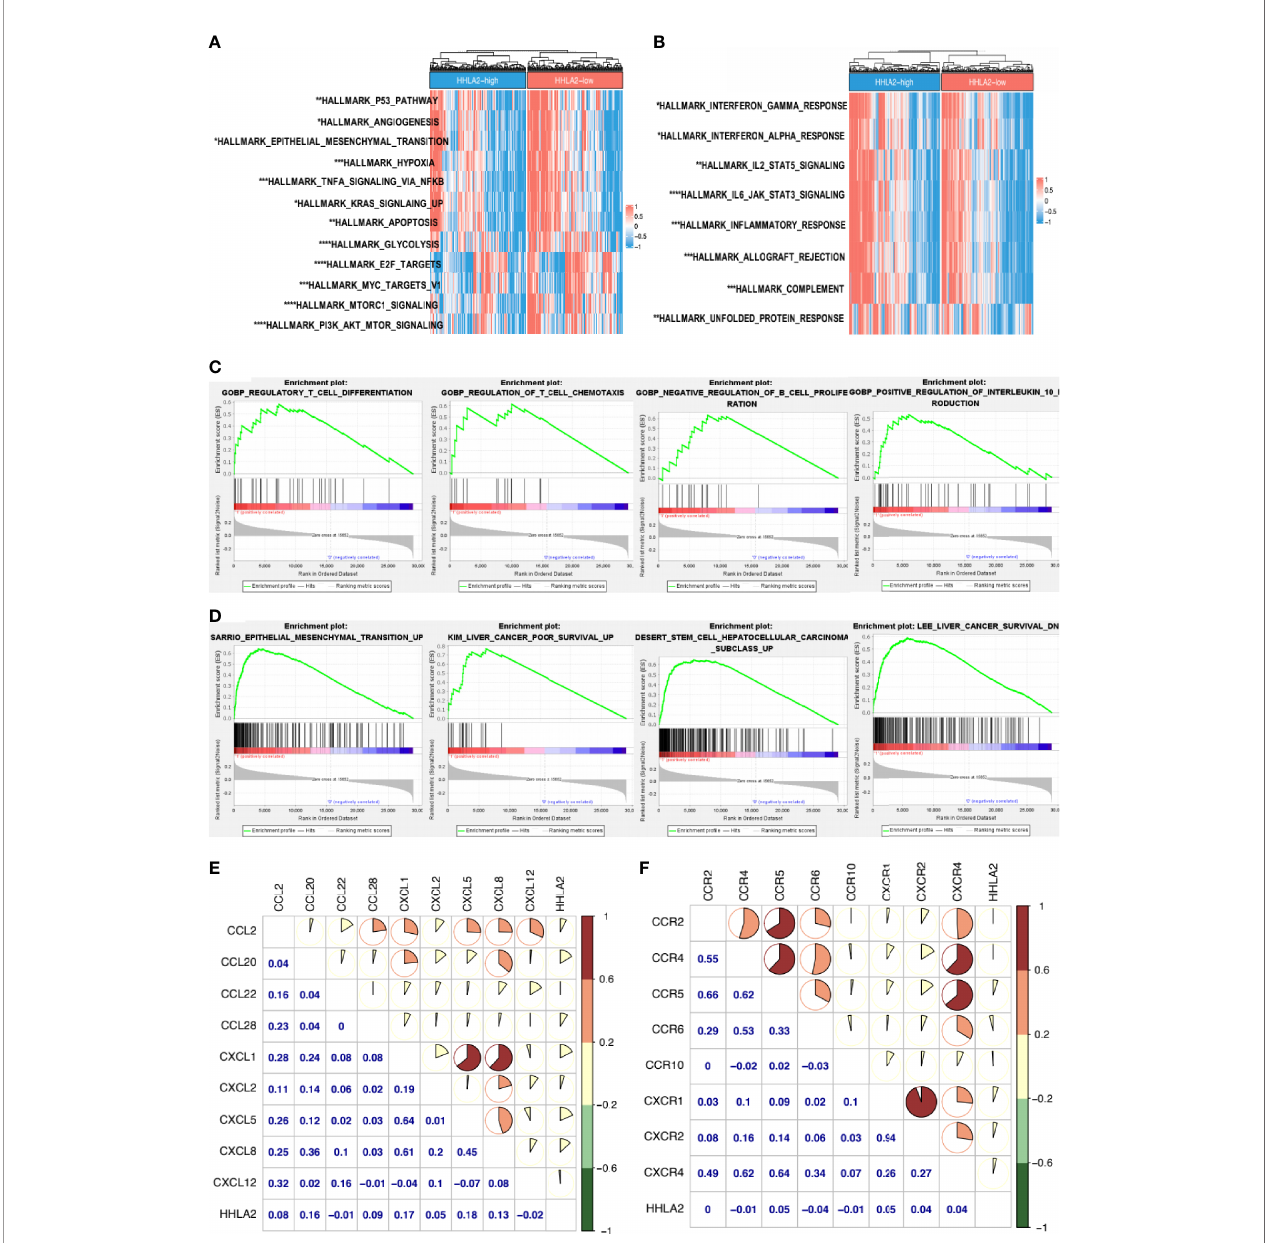
FIGURE 6 | Uncovering the driving mechanisms behind HHLA2 high expression and tumor malignancy. (A) Comparison of hallmark pathways between HHLA2-high and -low subgroups. (B) Comparison of hallmark immune-related signatures between subgroups. (C) GSEA enrichment results of HHLA2-high groups in GO-BP. (D) GSEA enrichment analyses of HHLA2-high groups in C2-CGP. (E) Correlation among HHLA2 mRNA level and speci fi c chemokines. (F) Correlation among HHLA2 expression level and several receptors. *p < 0.05, **p < 0.01, ***p < 0.001, ****p <